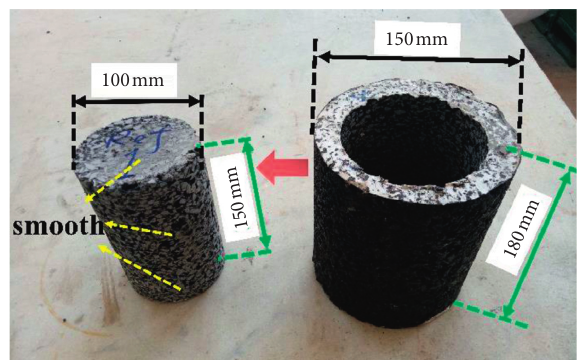
Figure 4: Sample preparation.